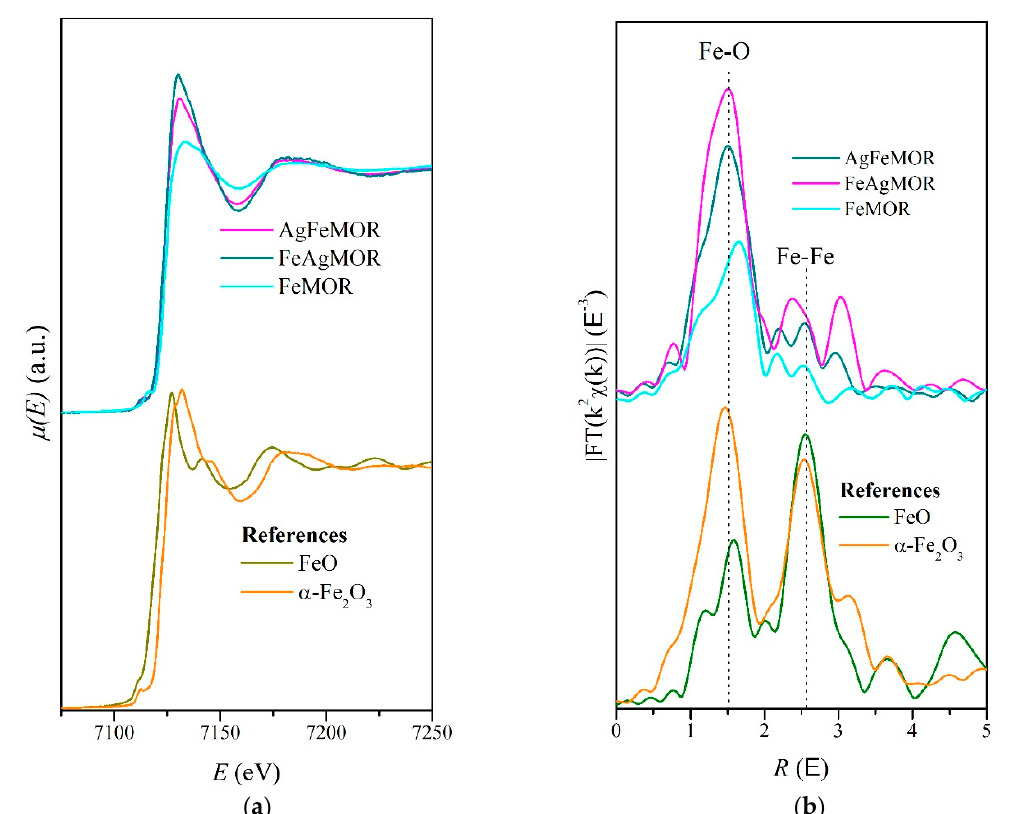
Figure 2. Fe K-edge XANES-spectra (normalized X-ray absorption spectra). ( a ) X-ray Absorption Near-Edge Structure (EXAFS) pattern and ( b ) Fourier transforms taken in the k-range of 2 to 12 Å − 1 .